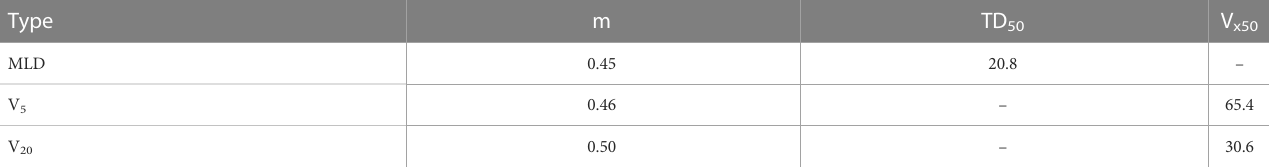
TABLE 3 Parameters used to calculate